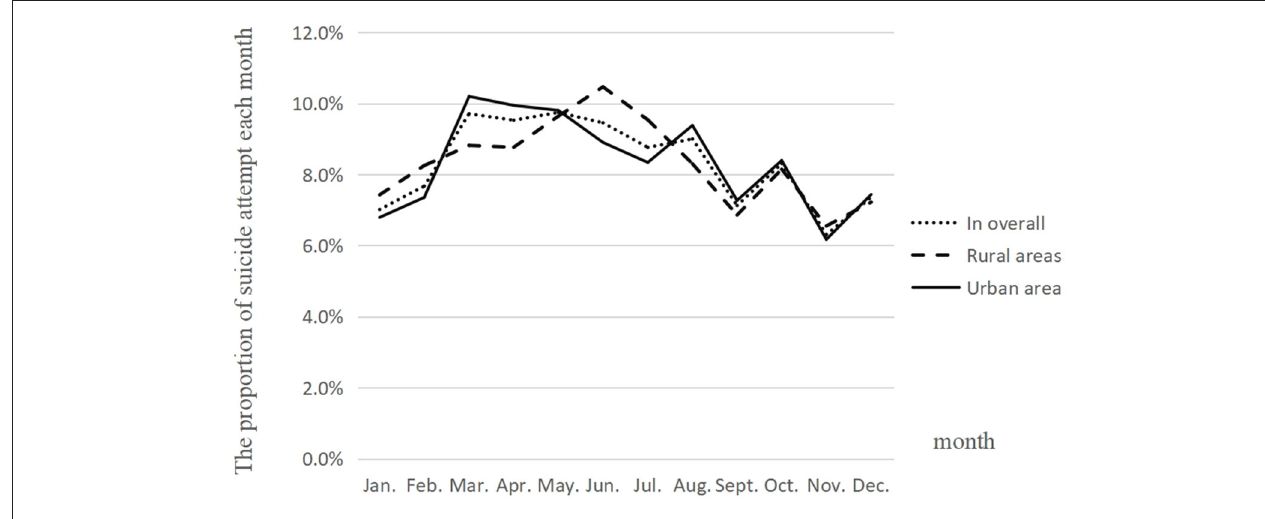
FIGURE 1 | Monthly distribution of suicide attempts registered in the rural and urban areas.